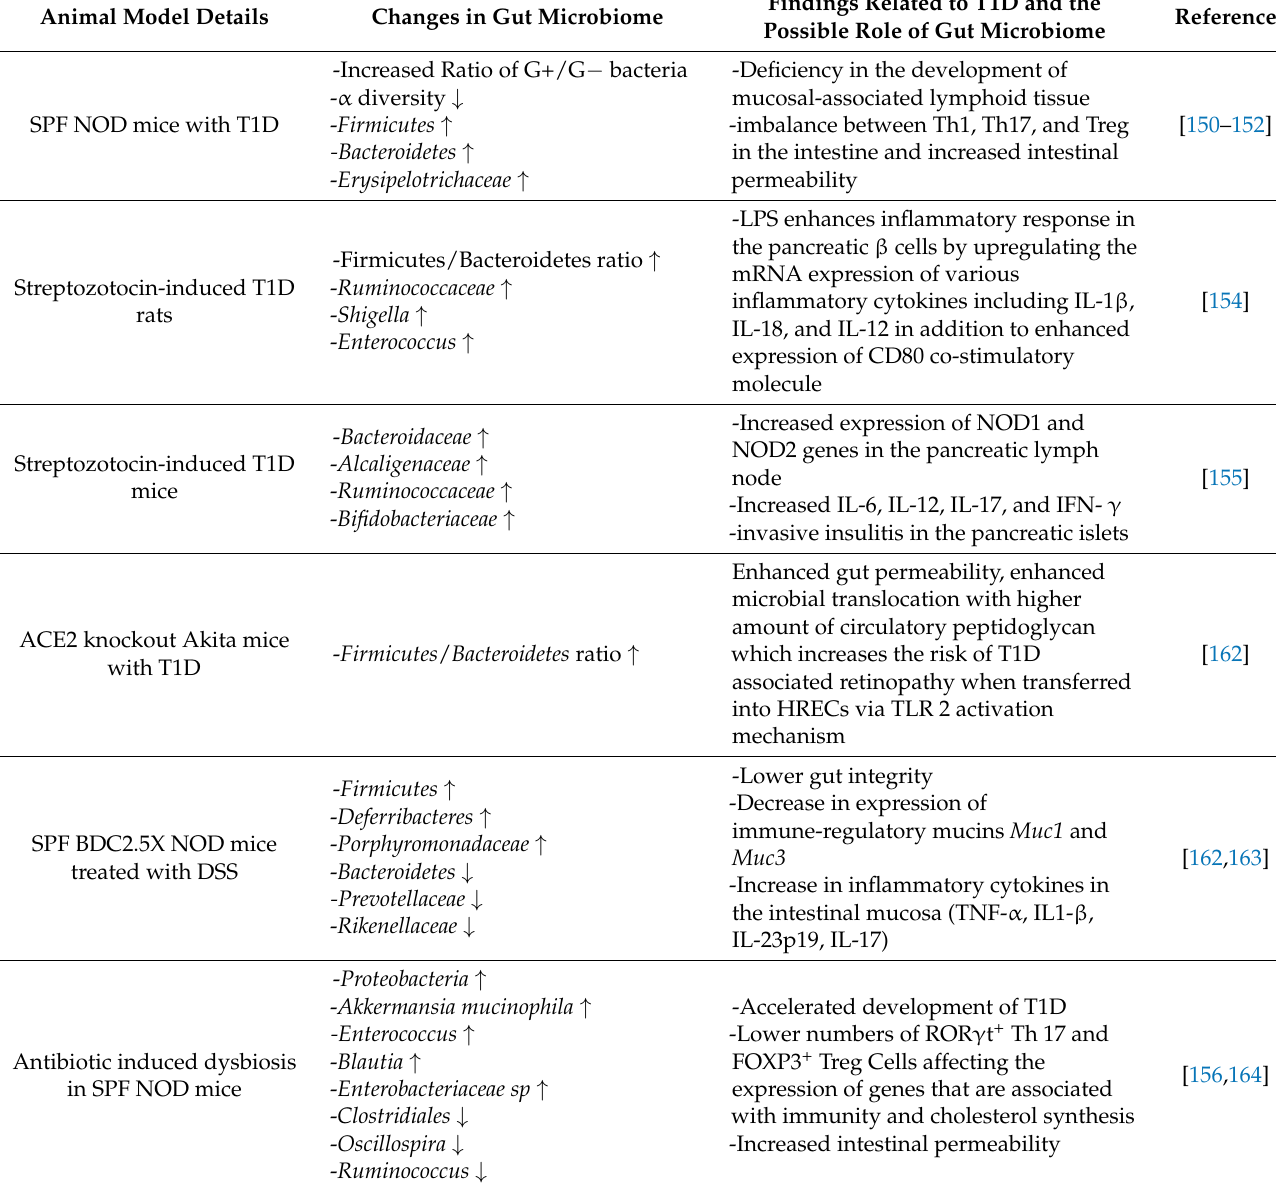
Table 2. Changes in gut microbial composition related to T1D in different animal